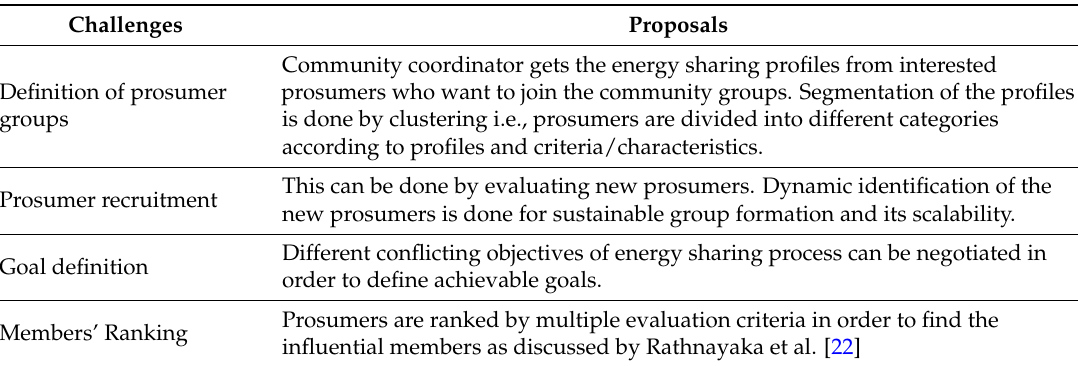
Table 1. Prosumer community challenges and proposed